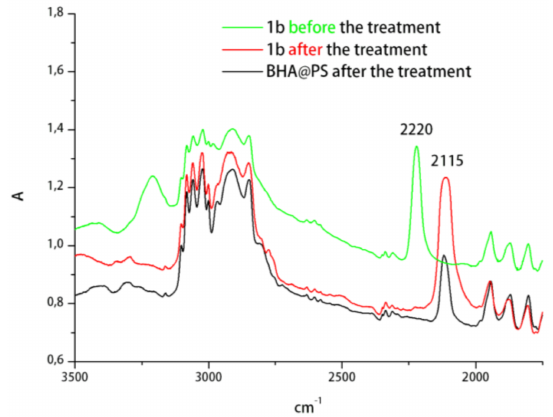
Figure 6. IR spectra of 1b before (green) and after (brown) the treatment with Et 3 N and originally Pd-free resign (black) after the solution transfer